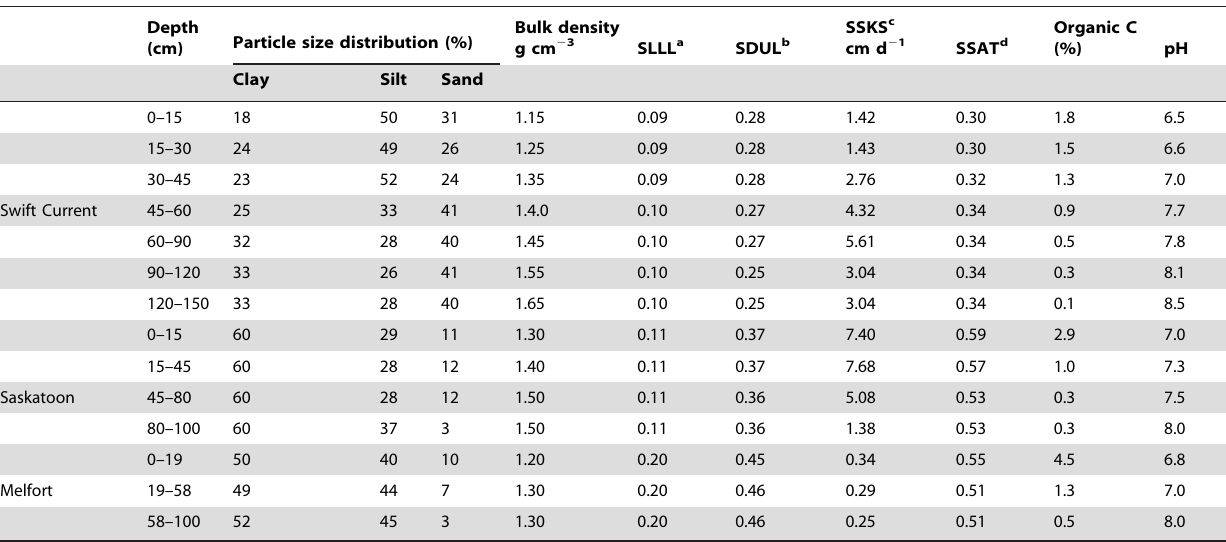
Table 1. Soil physical properties in the experimental